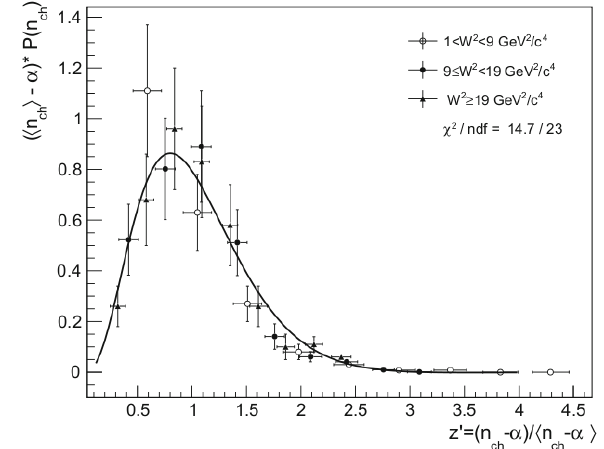
Figure 6. Koba-Nielsen-Olesen (KNO) scaling distribution. The parameter α = results of the fit on D ch